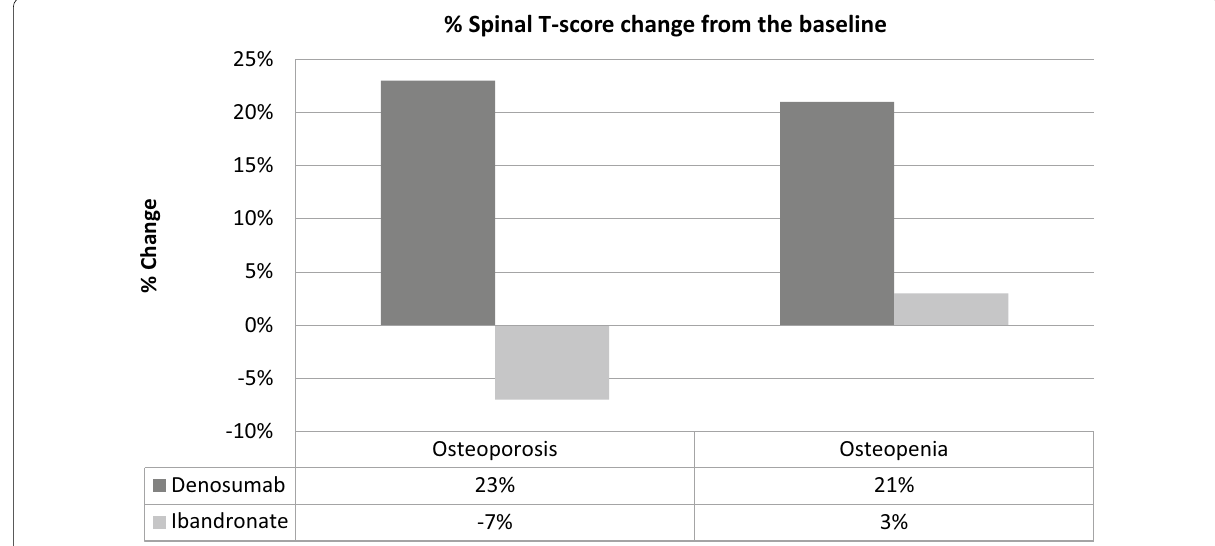
The data shows the percentage change in the spinal T-score from the baseline after one year of treatment, Fig. 1 Percentage Spinal T‑score change from the baseline